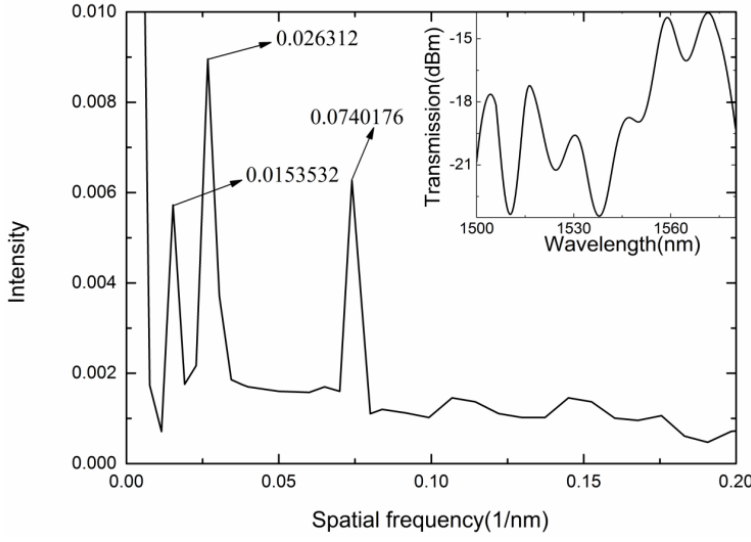
Figure 7. The spatial frequency spectrum of the cascade system and the inset is the corresponding spectrum.